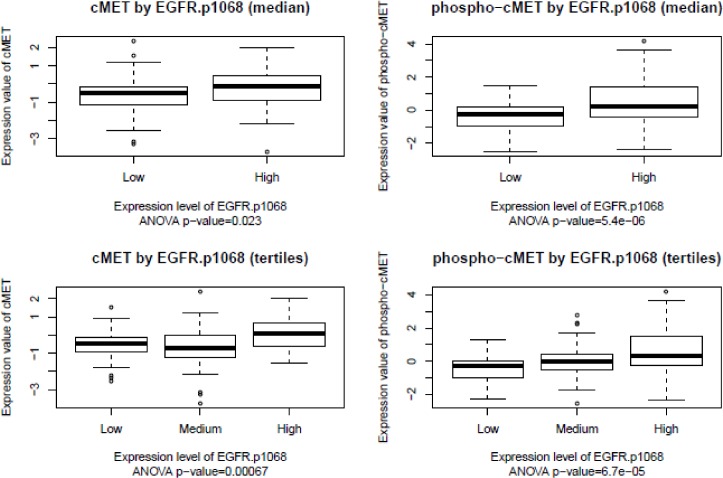
Boxplot of cMET and p-cMET by EGFR phosphorylation.The boxplots of expression and phosphorylation values of cMET with different expression levels of EGFR.p1068 in HER2 positive breast cancers is shown. The cutoffs of EGFR.p1068 expression levels were based on median or tertiles of the expression values of EGFR.p1068. The ANOVA p-values testing comparison significance are shown.